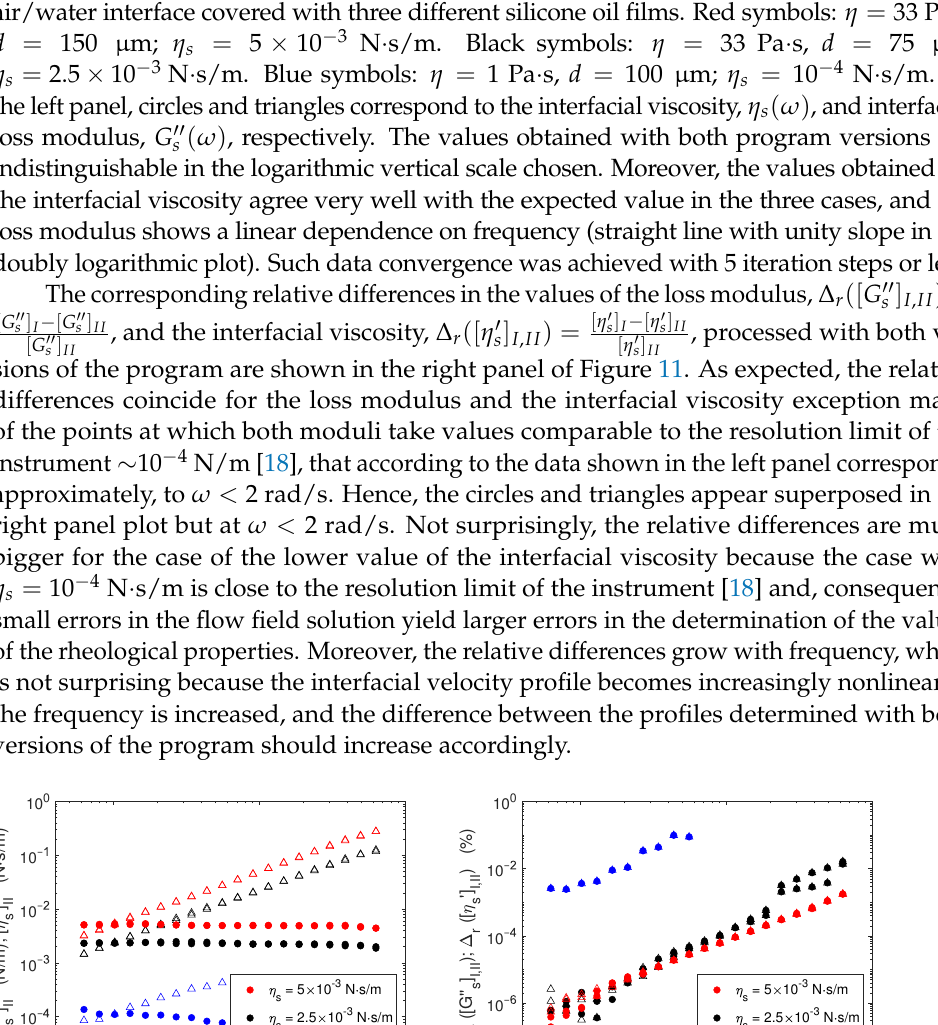
η s = 2.5 × 10 − 3 N · s/m. Blue symbols: η = 1 Pa · s, d = 100 µ m; η s = 10 − 4 N · s/m. In